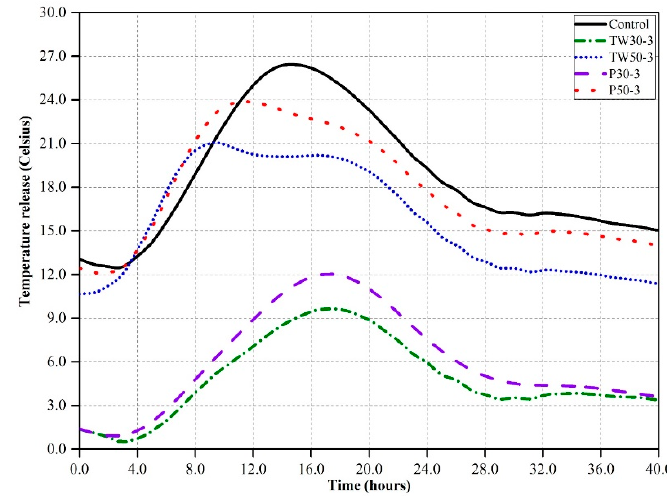
Figure 3. Temperature release of the control mix and mixes containing 3% ICA over 40 h.